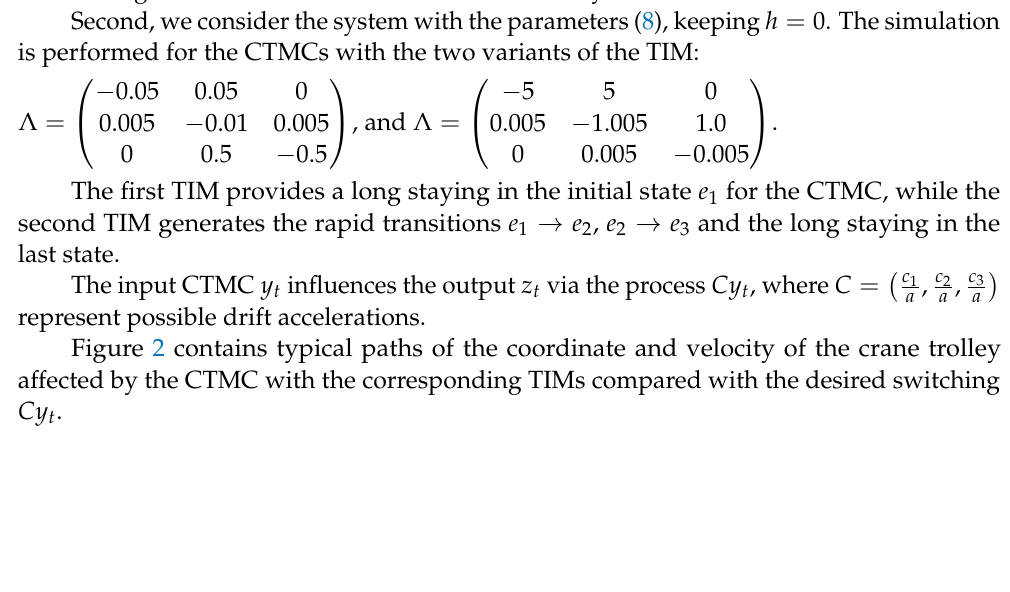
Figure 1. Typical state trajectory of the model without the drift y t : 1—coordinate x t ; 2—velocity v t . The figure confirms the stable character of the